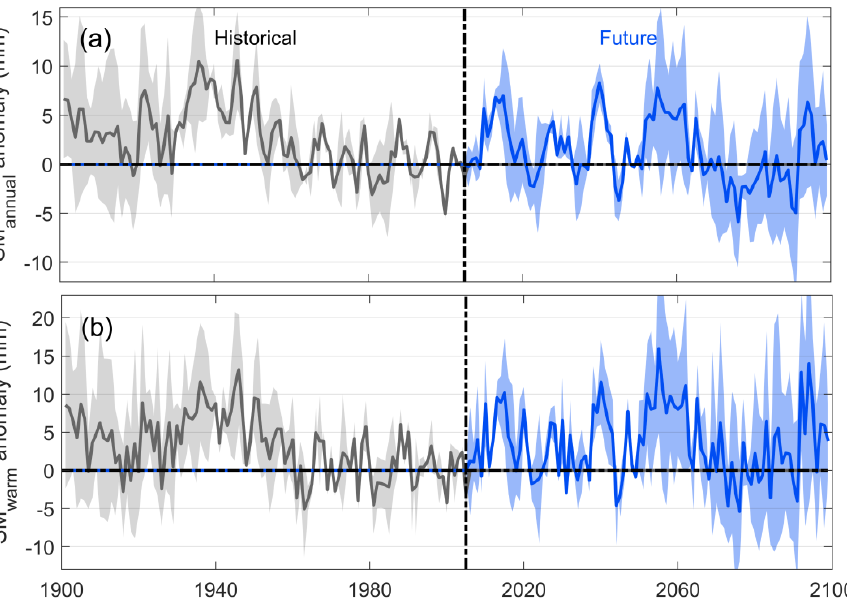
Figure 1. Long-term variation in soil moisture anomalies based on process-model simulations. ( a ) Annual SM; ( b ) warm-season SM. SM anomalies are relative to the distance to the mean during 2006 – 2015. The shaded line is the doubled standard deviation between the four models. The warm seasons mentioned are the three months with the largest annual mean temperatures in 1901 – 2005.